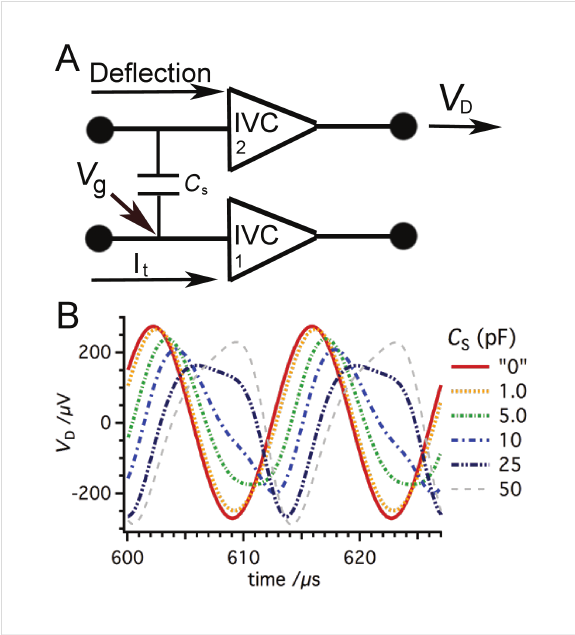
Figure 4: (A) The coupling between the deflection and the tunneling current channel is established by the stray capacitance C s . To show the effect of the cross talk, signals shown in Figure 1 were used as input values for the amplifiers. (B) The signal in the deflection channel is altered significantly at the output V D for C s values exceeding 1 pF.